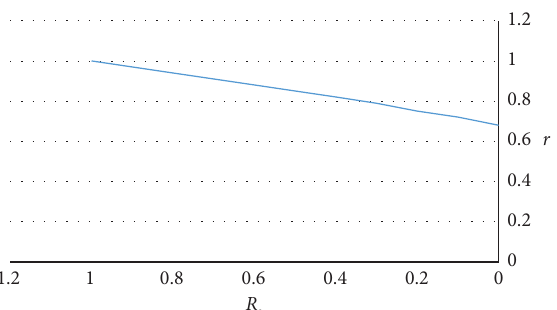
Figure 7: Te confdence chart of 􏽥 U